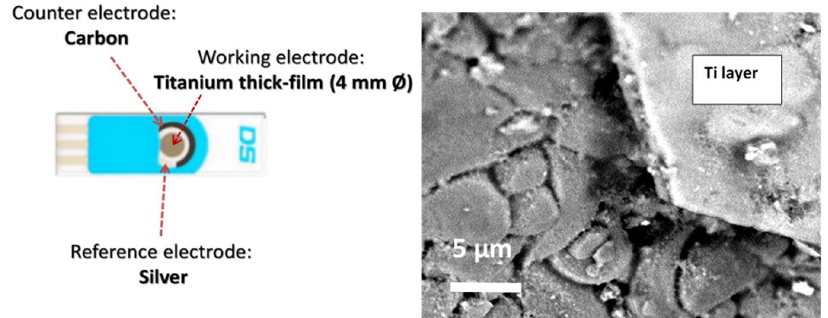
Figure 1. Diagram of the electrochemical sensing platform used ( left ). SEM image showing a cross section of the thick titanium layer (about 1.5 µm) on the alumina substrate ( right ).